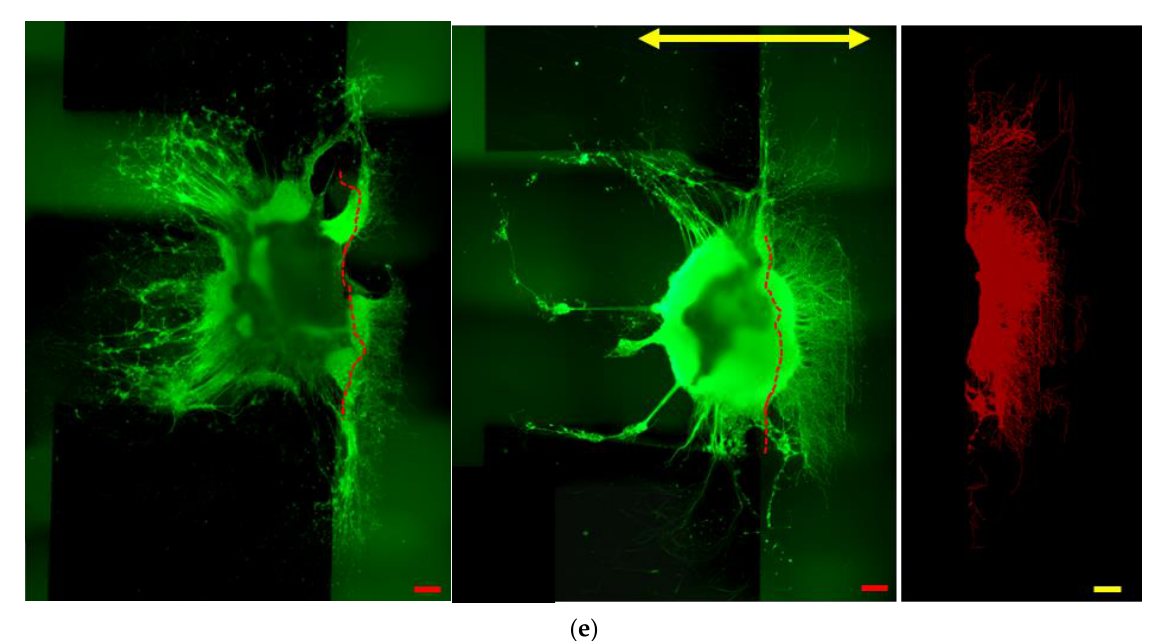
Figure 6. Immunostained images of the in vitro reconstructing process of a damaged neuronal cell colony. Left side figures are the static case (control, without micro dynamic stimulation) for comparison. Right side figures are the case under micro dynamic stimulation (vibration total amplitude: 60µm, frequency: 5 Hz, 12 h. interval). ( a – d ) are stained by NeuroFluor NeuO, while ( e ) by β Ⅲ -tubulin. Figures in green show direct microscopic images. The right end figures in red show area presumed to be cut off and lost: A lost . ( a ), or reconstructed area: A reconst. ( c – e ). These are binarized images by utilizing WinROOF in case of micro dynamic stimulation. The dotted red line shows the approximate cutting line which is given from ( b ), and the yellow arrow shows the direction of vibration stimulation. ( a ): Just before cutting damage is conducted (day 5). ( b ) : Immediately after cutting damage (day 5). ( c ) : Initial reconstructing process (day 7 or 2 days after cutting damage). ( d ) : Middle of the reconstructing process (day 9 or 4 days after cutting). ( e ) : Reconstructed final image (day 11 or 6 days after cutting). It is clearly seen that neurites are sprouted around the seeding pit. Reconstructed neurites are dramatically sprouted to the right-hand direction, especially in a micro dynamic stimulation case. (scale bars = 200 µm).